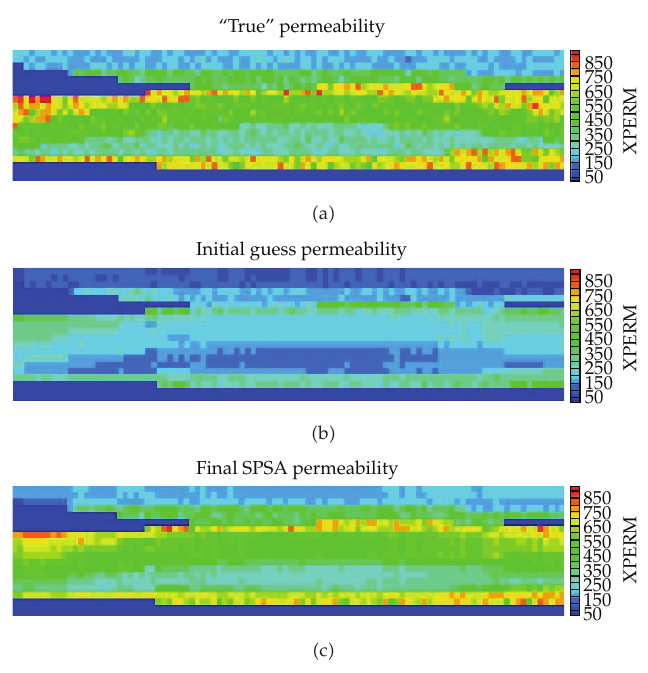
Figure 7: Example 1: permeability estimation using SPSA.